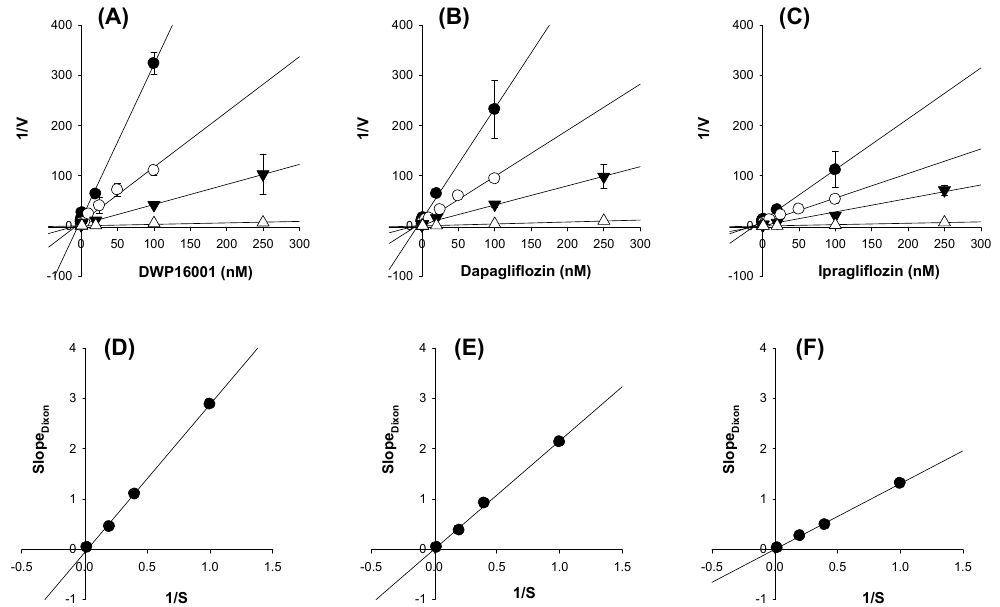
Figure 10. Dixon plot for the inhibitory effect of ( A ) DWP16001, ( B ) dapagliflozin, and ( C ) ipragliflozin on the uptake of [ 14 C]methyl-a-D-glucopyranoside (AMG) in CHO-SGLT2 cells. Each symbol represents the concentration of [ 14 C]AMG: ● , 1 µM; ○ , 2.5 µM; ▼ , 5 µM; , 50 µM. Replot of the slopes of Dixon plot (slopes vs 1/[S]) was shown for ( D ) DWP16001, ( E ) dapagliflozin, and ( F ) ipragliflozin. V indicates the SGLT2-mediated uptake rate of [ 14 C]AMG and S indicates the concentration of [ 14 C]AMG. The data are the means±standard deviations of triplicate measurements.